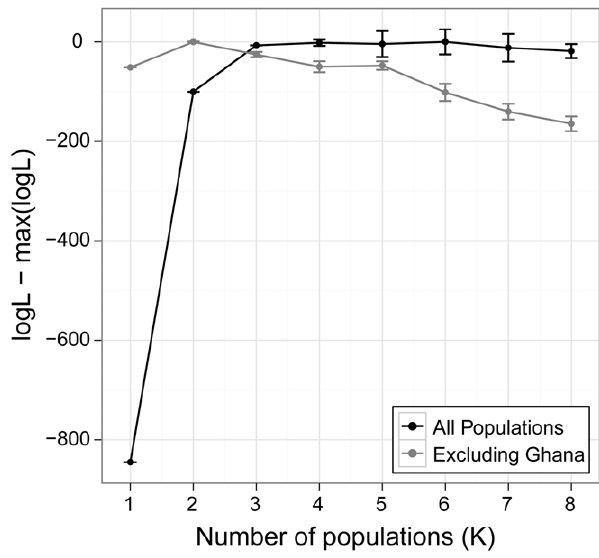
Figure 1. Estimates of the most likely number of populations in a worldwide sample of D.melanogaster . The difference between the maximum likelihood and the likelihood for each estimate of K (the number of populations) is shown. Two analyses were carried out; one including all populations, and one excluding the population from Ghana.